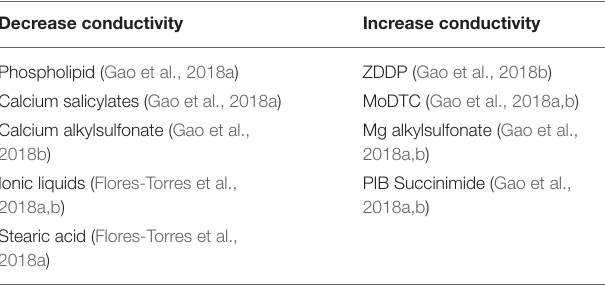
TABLE 7 | The additives that change lubricant